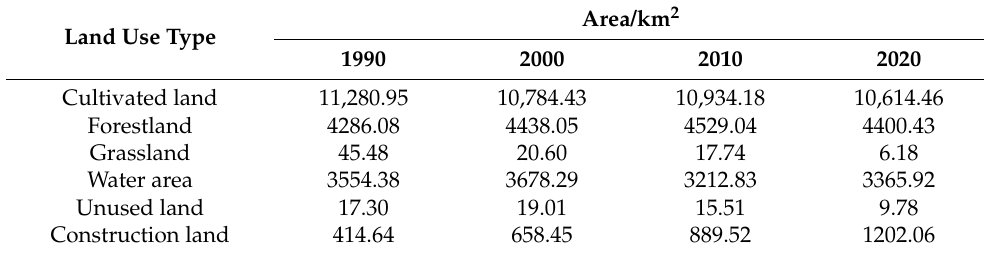
Table 2. Areas of land use types from 1990 to 2020.